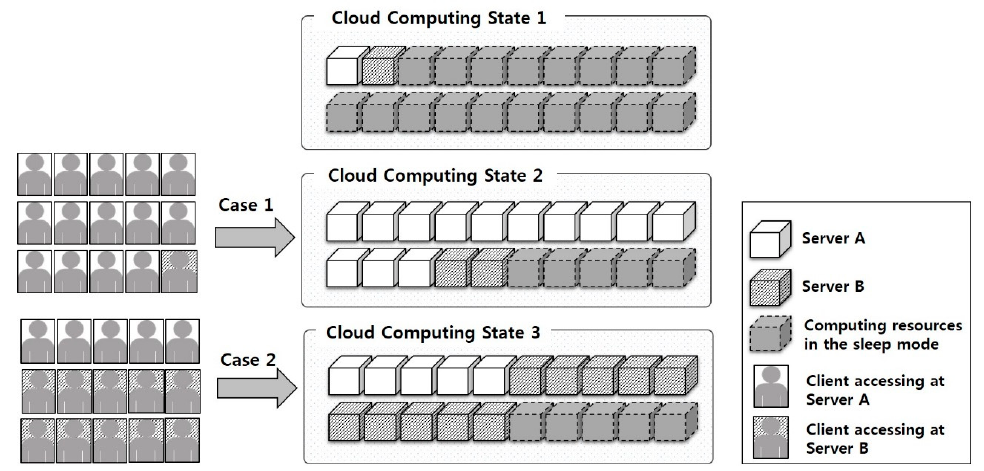
Figure 1. Basic concept of horizontal auto-scaling, edited from Reference [4].